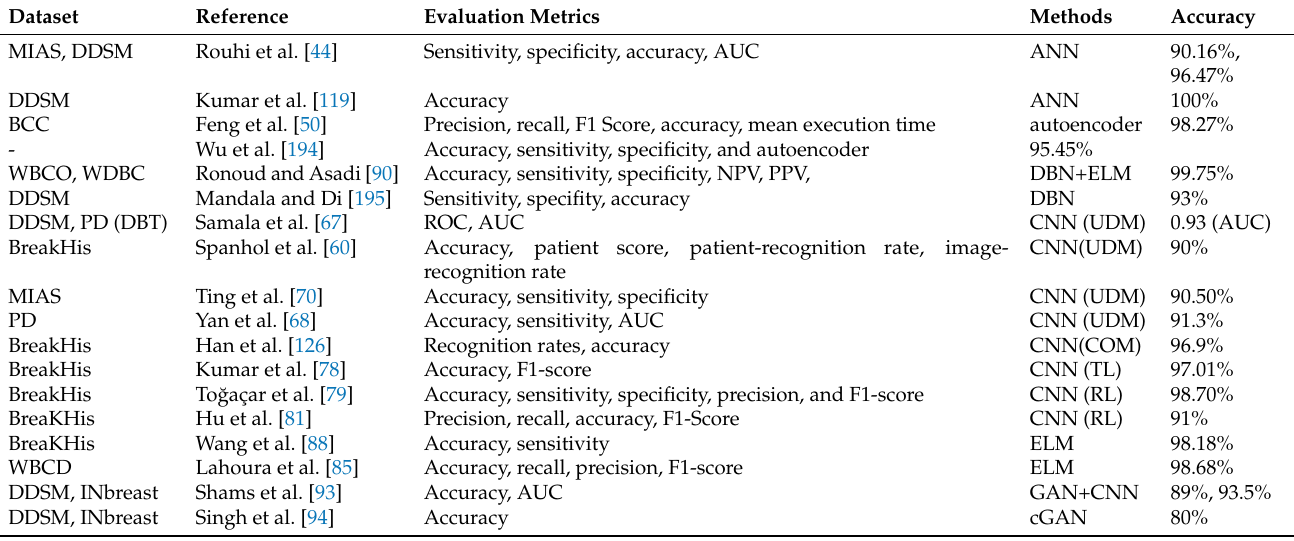
Table 12. An overview of datasets, references, methods, evaluation metrics, and accuracy.